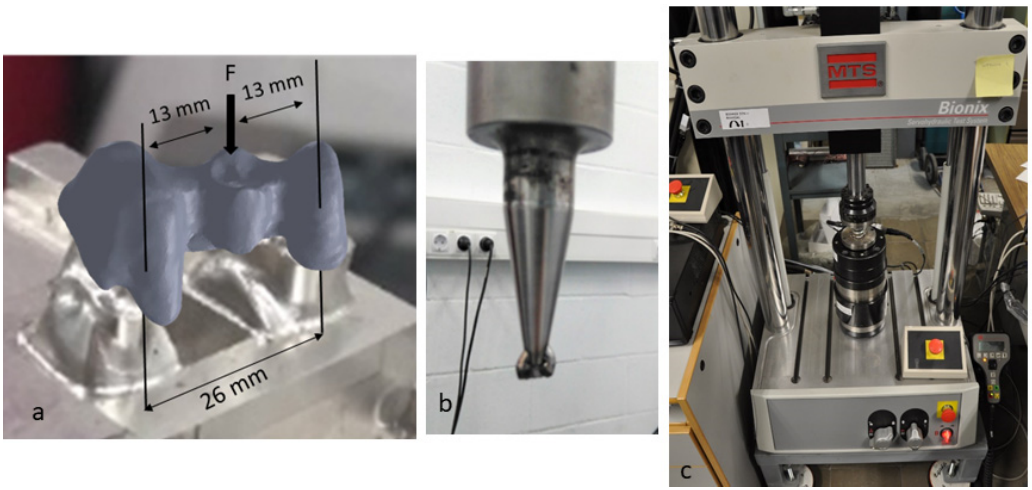
Figure 3. Overall 3-Point Flexure test set-up. ( a ) Lower clamp used for sample positioning, ( b ) Upper clamp used for load application, c ) MTS Bionix 370 Servo-hydraulic universal testing machine.